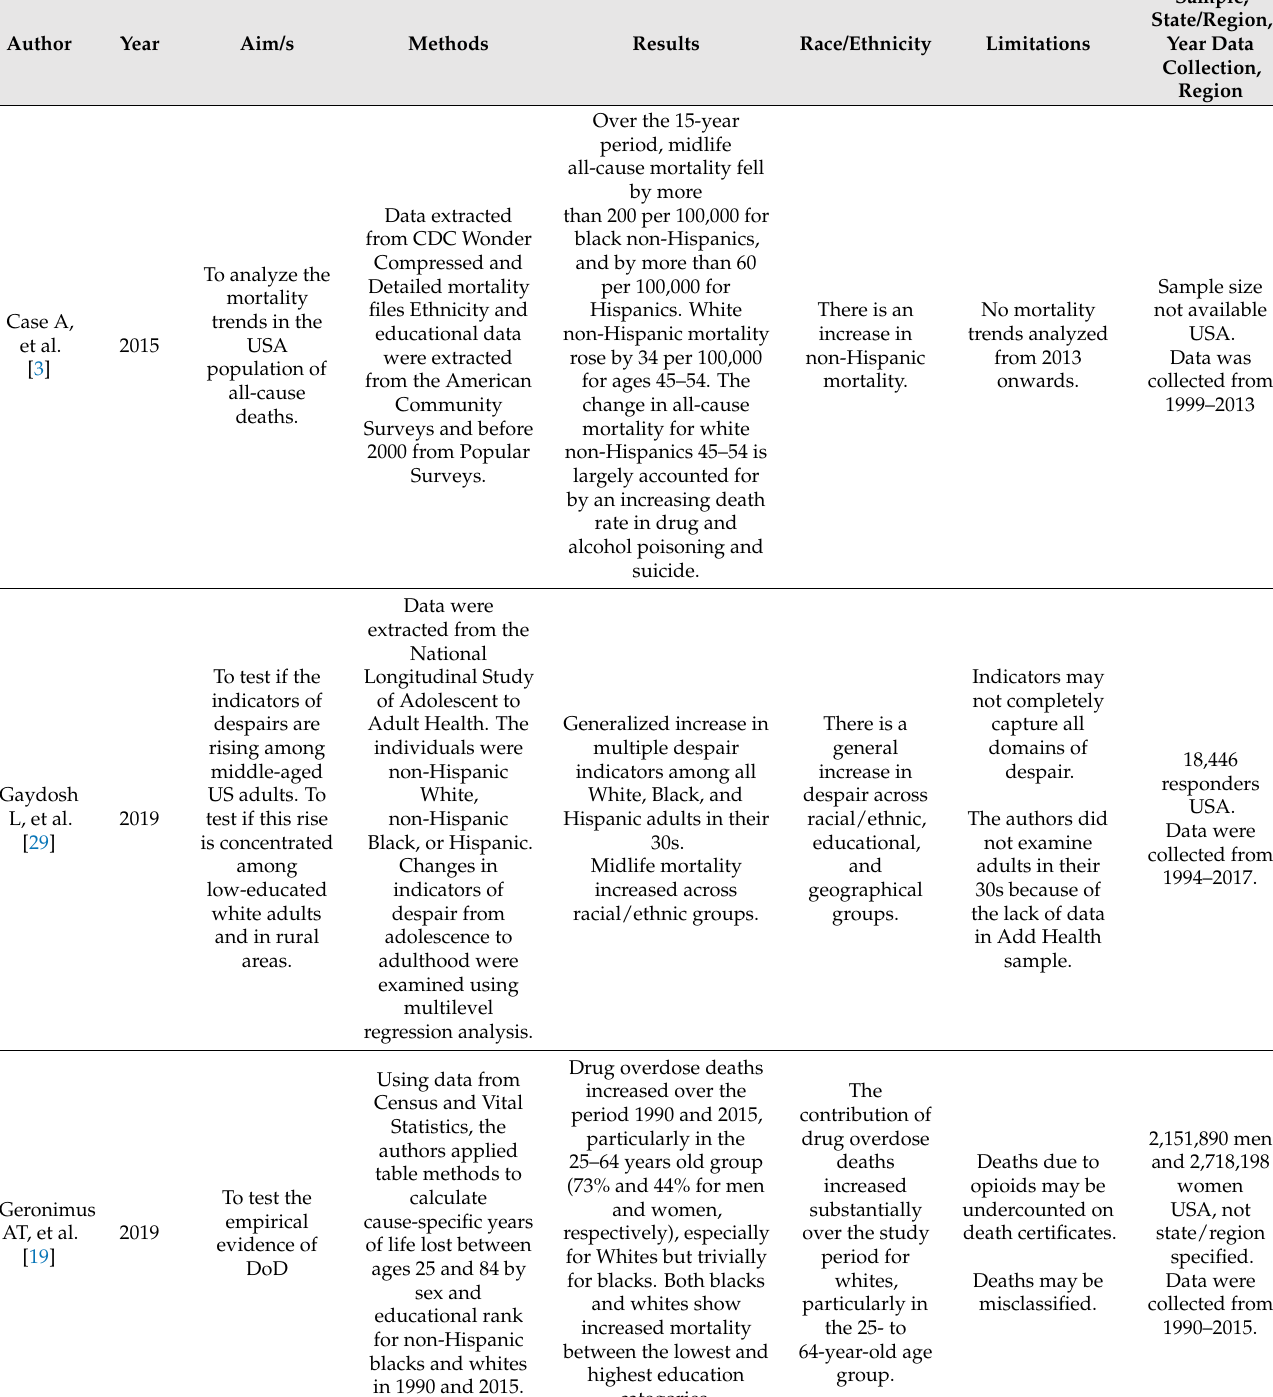
Table 3. Studies addressing Deaths of Despair according to education